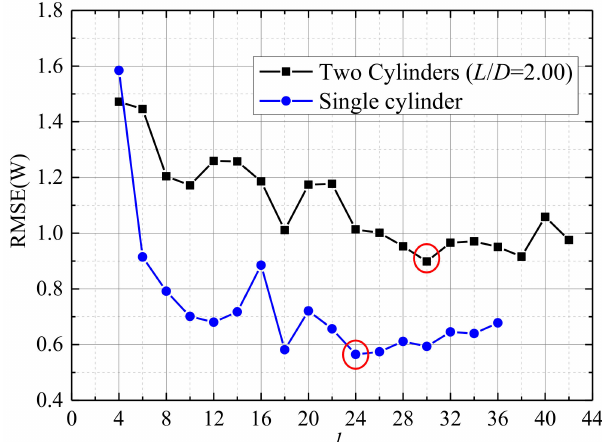
Figure 4. Relation between the RMSE of BP neural network and the number of the hidden layer nodes.